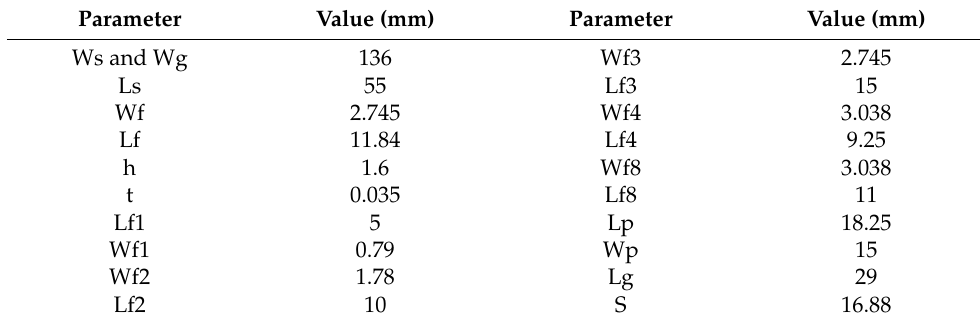
Table 1. Optimum parameters for the 1 × 4 array antenna.